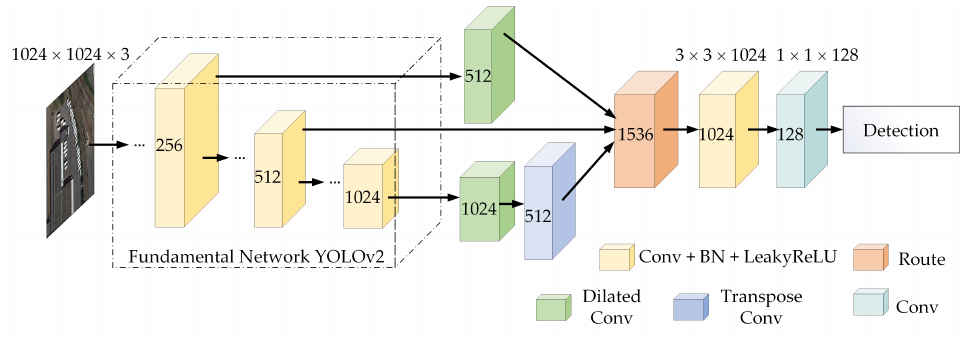
Figure 3. Structural overview of the improved YOLOv2